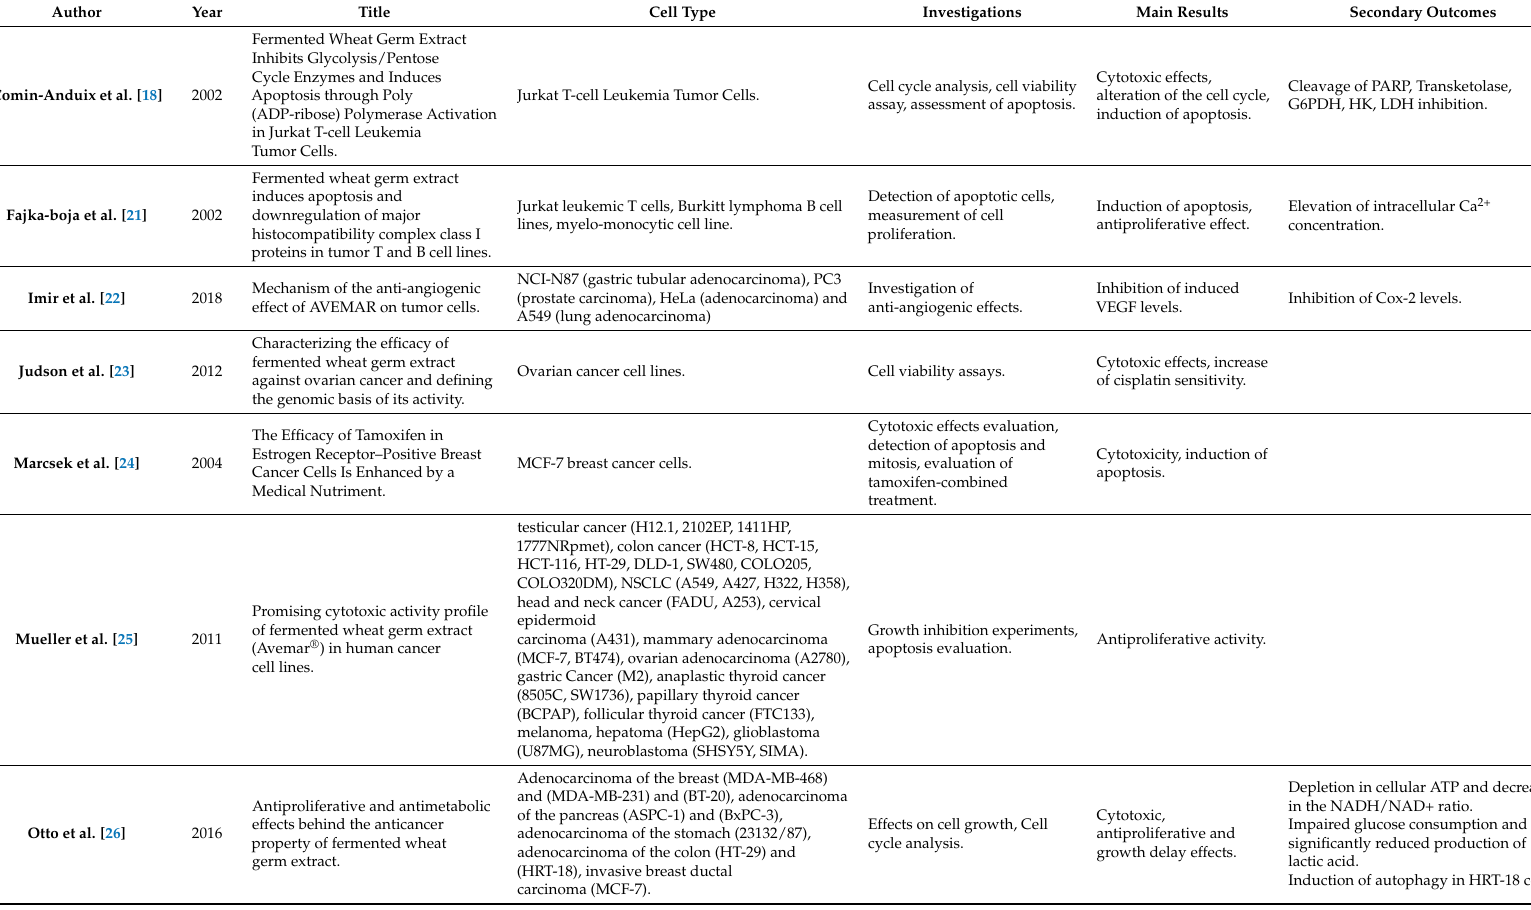
Table 1. Main data of the included studies, reporting the first author, the year of publication, the title, the types of the cells subjected to the treatment, the investigation procedures performed, and the main results of the